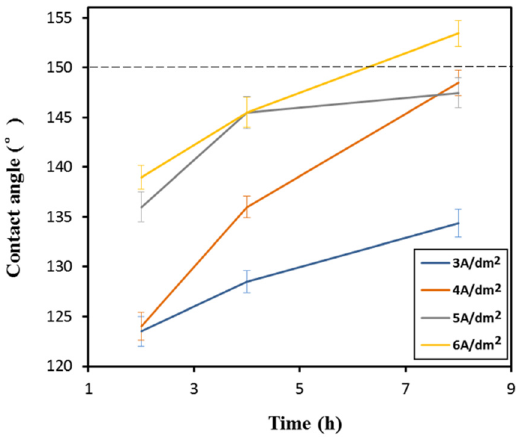
Figure 2. Annealing time-contact angle curves of samples prepared with different plating parameters.